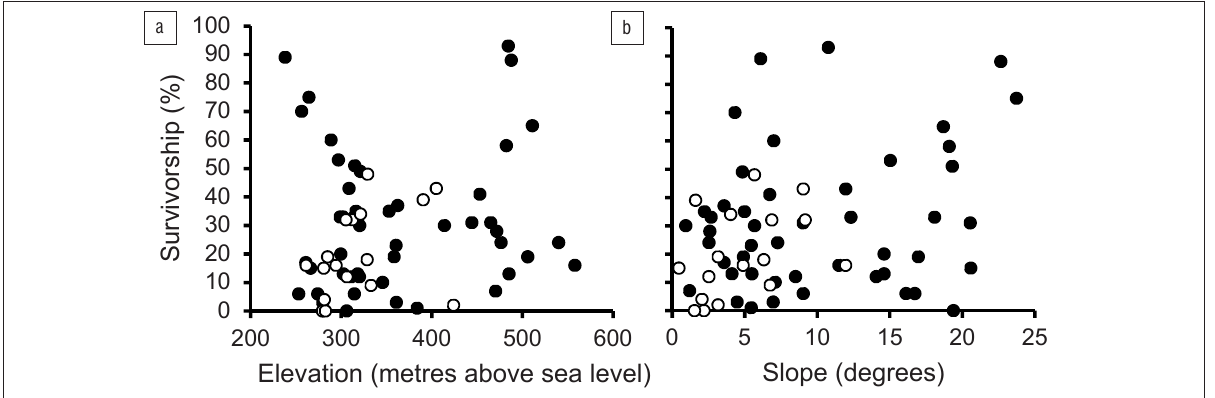
Figure 3: Spekboom cutting survivorship in relation to (a) elevation and (b) slope in Addo Elephant National Park (solid circles) and Great Fish River Nature Reserve (open circles).